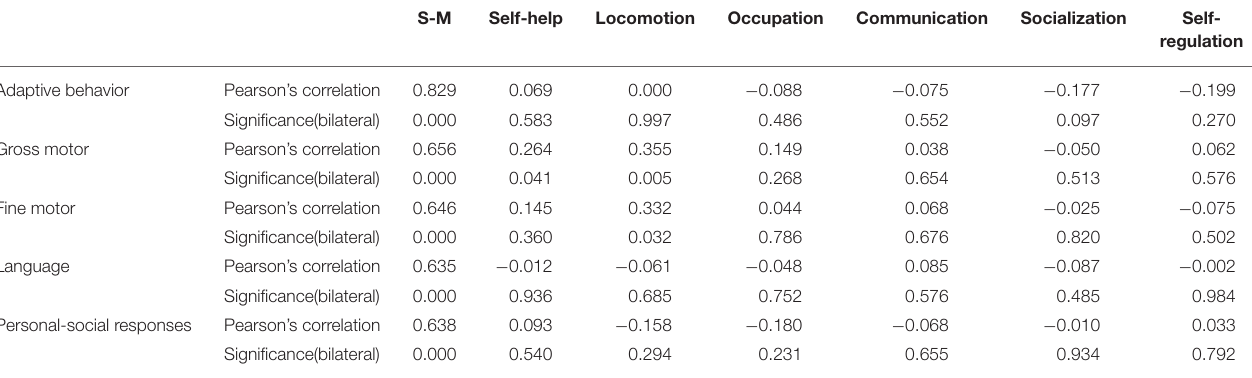
TABLE 5 | Association of domain skills between the GDDS and S-M in